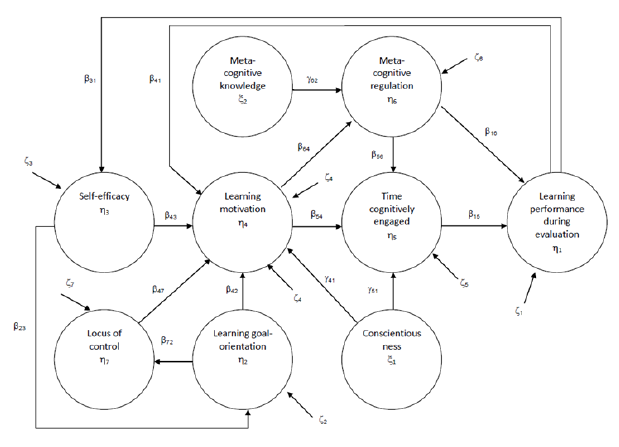
Figure 2: Reduced Van Heerden – De Goede learning potential structural model